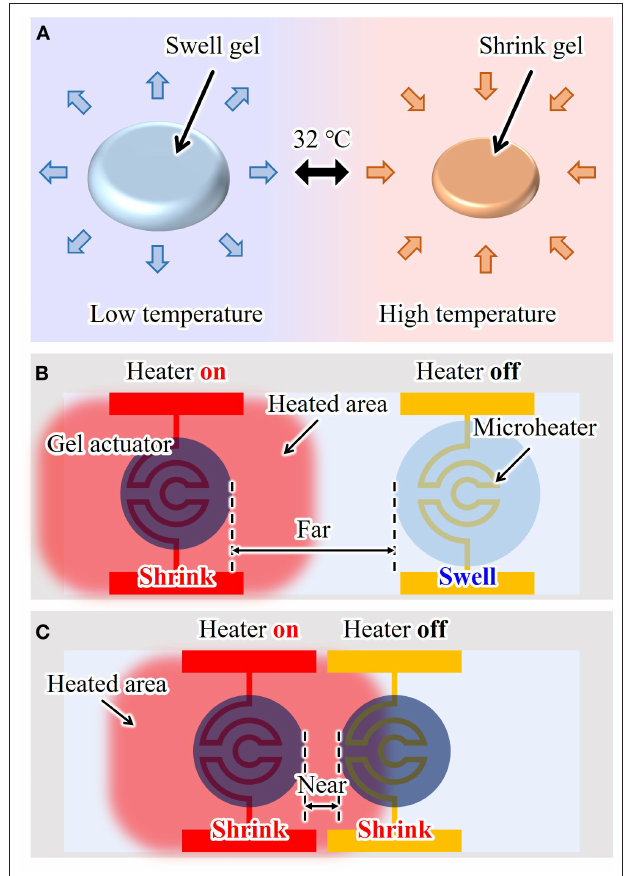
FIGURE 1 | On-chip hydrogel microactuator: (A) working principle, (B) conventional drive method, and (C) a problem of conventional drive method due to heat dissipation when the actuators are integrated in short